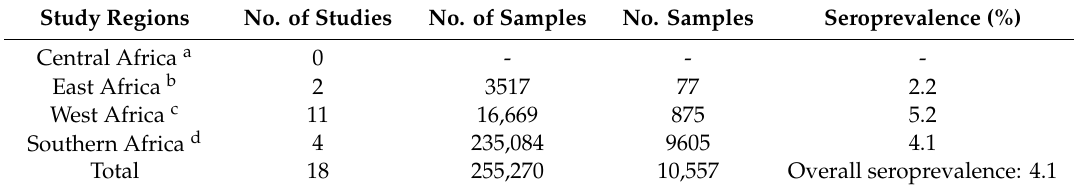
Table 2. Seroprevalence of AIV in sub-Saharan Africa.